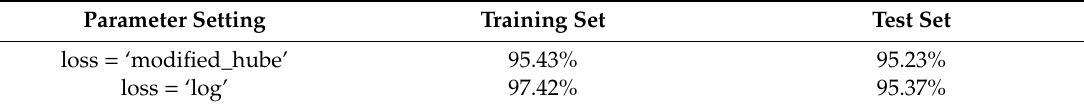
Table 13. The average training precision of di ff erent loss functions of the SGDClassifier.